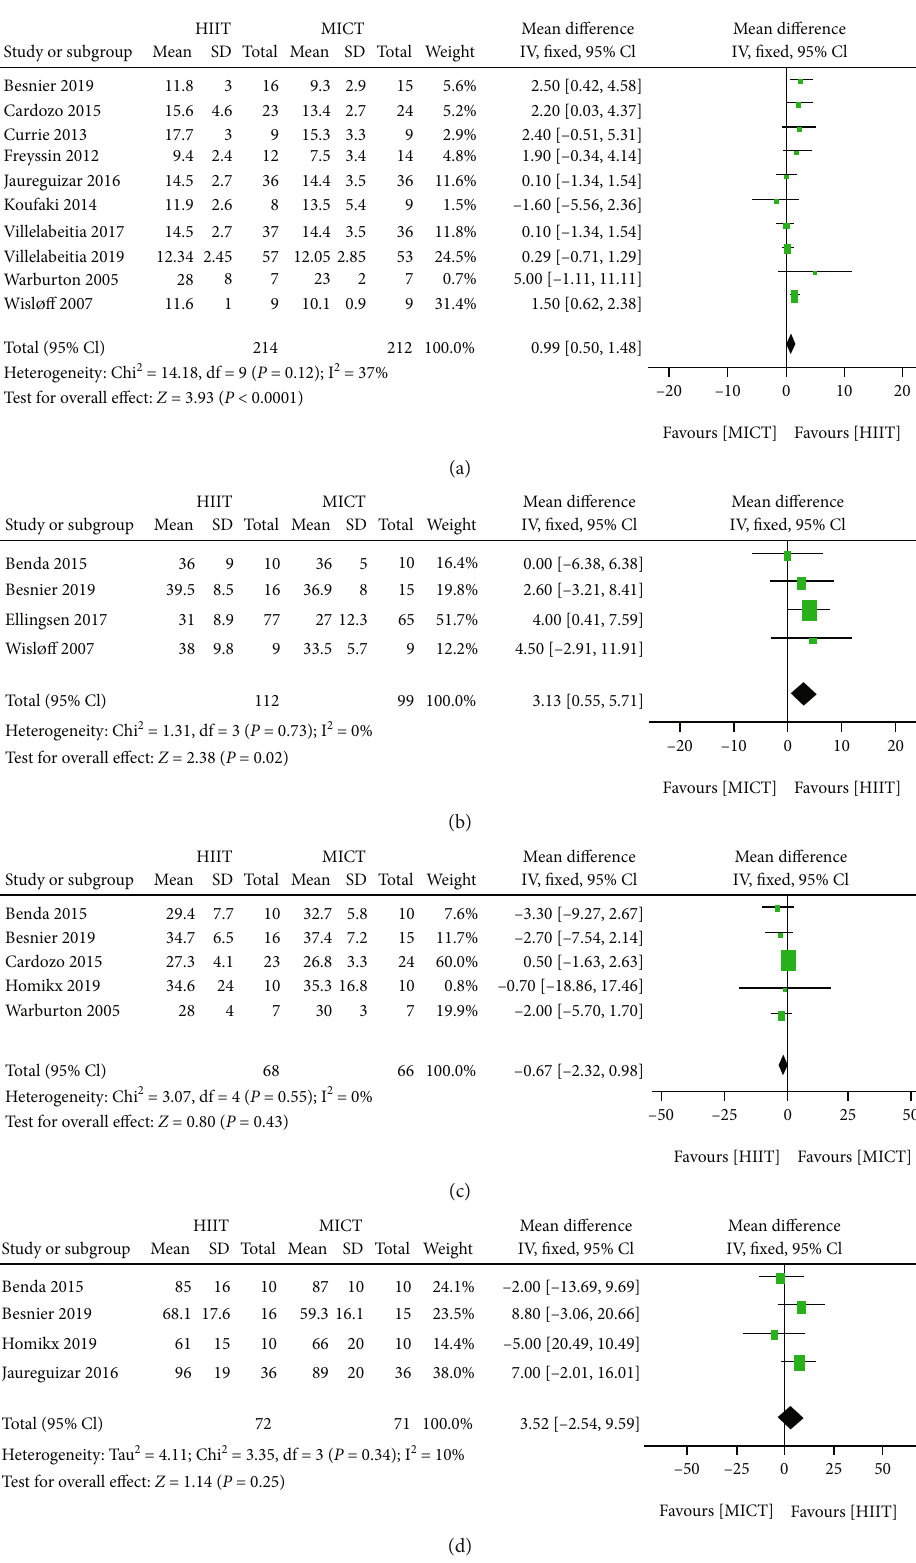
Figure 6: Forest plot summary of the e ff ect of HIIT and MICT on prognostic markers in patients with CAD and HF: (a) anaerobic threshold (AT); (b) left ventricular ejection fraction (LVEF); (c) the VE/carbon dioxide production (VCO ) slope (the VE/VCO slope); (d) the 2 2 prognostic value of percent predicted VO max (the predicted VO peak (%)). HIIT: high-intensity interval training; MICT: moderate- 2 2 intensity continuous training; CAD: coronary artery disease; HF: heart failure; SD: standard deviation; CI: con fi dence